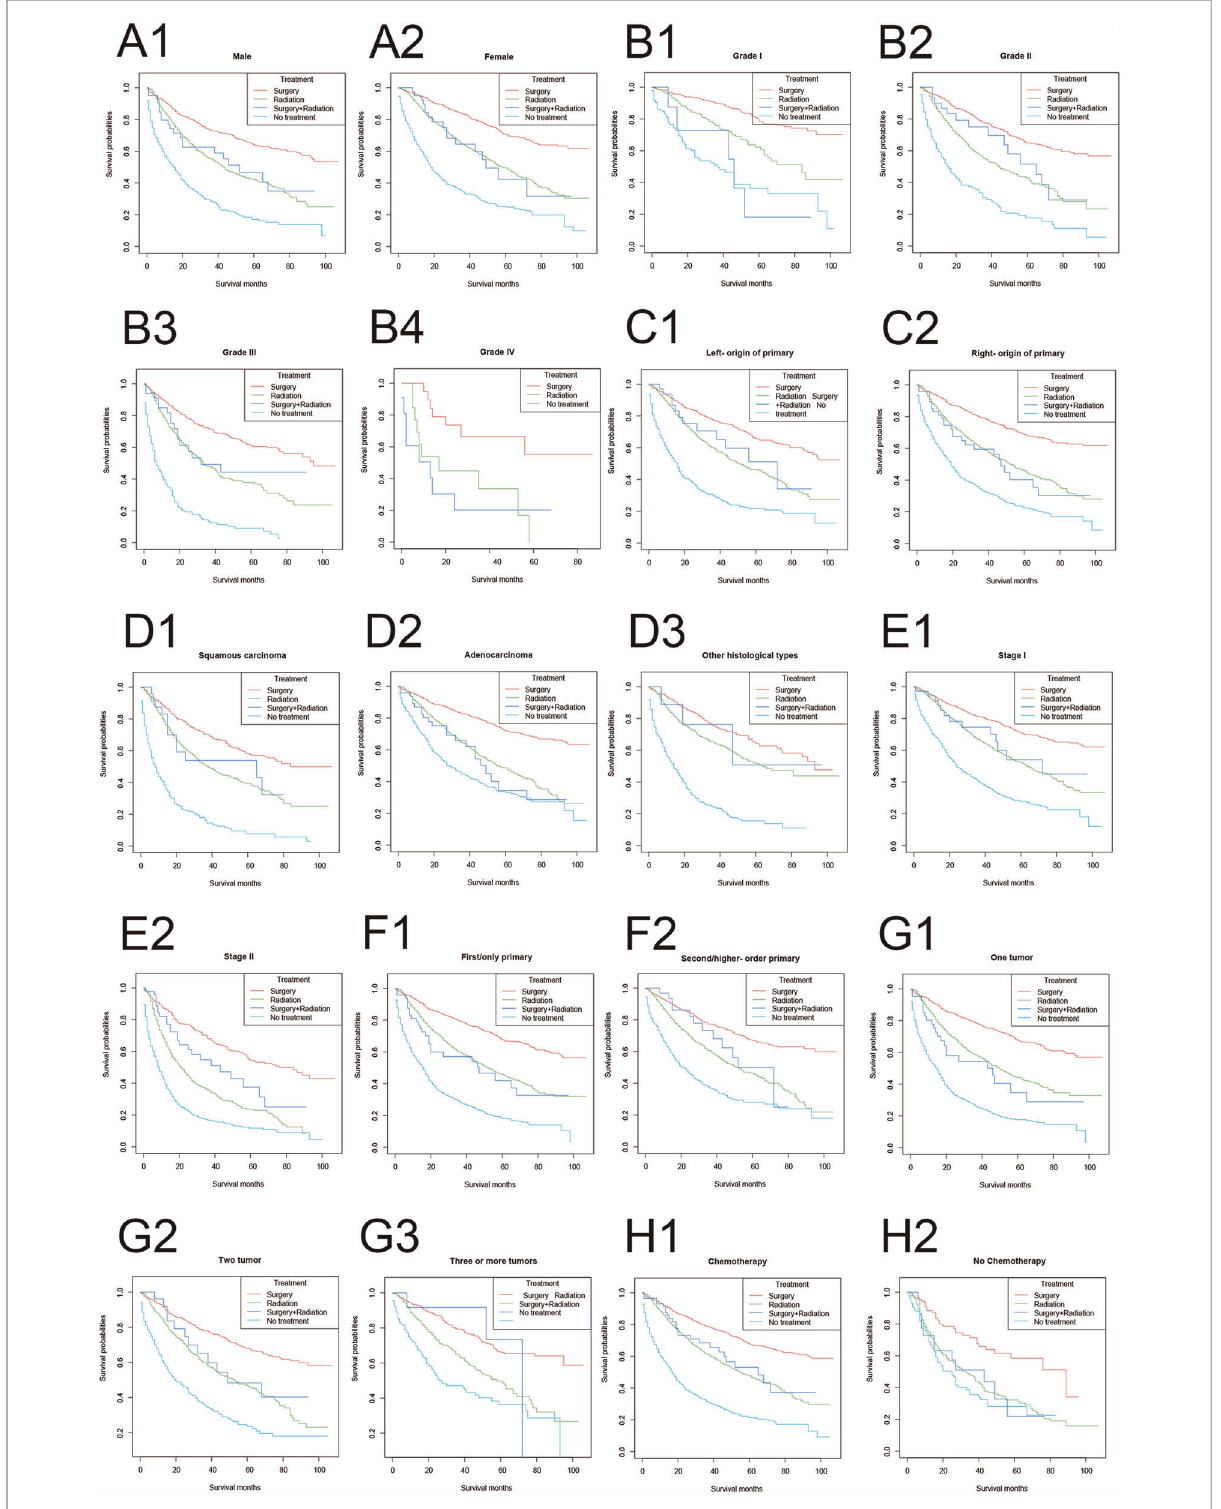
FIGURE 4 Lung cancer-speci fi c survival strati fi ed by treatment modalities among patients ≥ 80 years old with NSCLC in different strati fi cations. (A1 – A2) Strati fi ed by sex; (B1 – B4) strati fi ed by grade; (C1 – C2) strati fi ed by laterality; (D1 – D3) strati fi ed by histology; (E1 – E2) strati fi ed by stage; (F1 – F2) strati fi ed by sequence number; (G1 – G3) strati fi ed by number of tumors; (H1 – H2) strati fi ed by